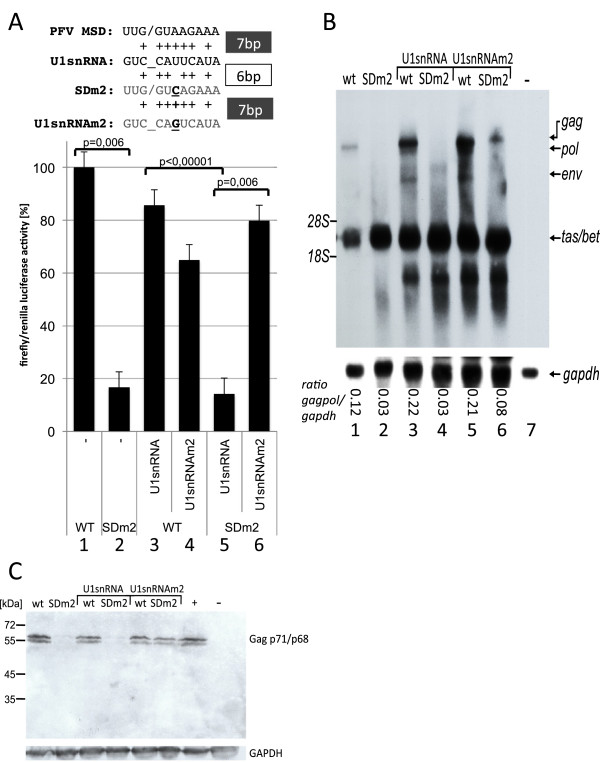
The occlusion of polyadenylation is U1snRNA-dependent. (A) Luciferase activity in BHK-21 cells. Co-transfection with the pGL3LTR derivatives and either wild-type or U1snRNAm2 expression construct complementary to SDm2. The latter restored suppression of polyadenylation in cells transfected with SDm2. An alignment of U1snRNA and splice donor RNA sequences is shown above the diagram (mutated nucleotides are shown in bold and underlined). Bars represent the mean value of three independent transfections, and the error bars represent the standard deviation. The significance of the reduction by the SDm2 mutation or increase by co-transfection of U1snRNAm2 was calculated by the paired two-sample t-test. p-values are indicated. (B) The SDm2 mutant is rescued by U1snRNAm2 co-transfection in a proviral context. Northern blotting analysis of RNA from BHK-21 cells co-transfected with either pHSRV13 or pHSRV13SDm2, and wild-type or SDm2 U1snRNA expression constructs. Viral RNAs were visualised using a tas-specific probe. The positions of the 18S (1.9 kb) and 28S (4.7 kb) rRNAs are indicated. The normalised amounts of gag/pol transcripts are depicted below the lanes. (C) Gag, Tas, and GAPDH were analysed by Western blotting. PFV-infected BHK-21 cells (+) and untransfected cells (−) served as controls.